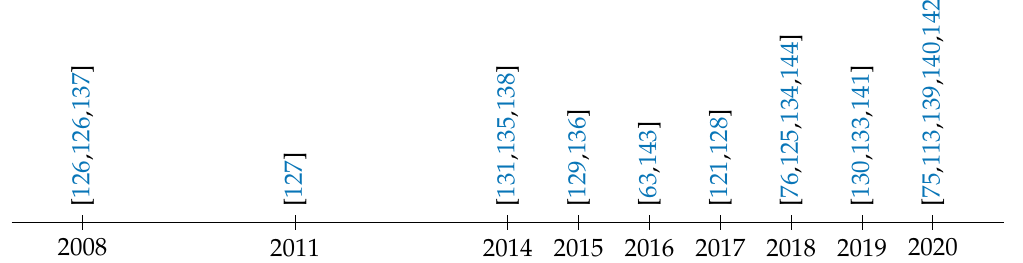
Figure 7. A timeline of different papers within the attack landscape